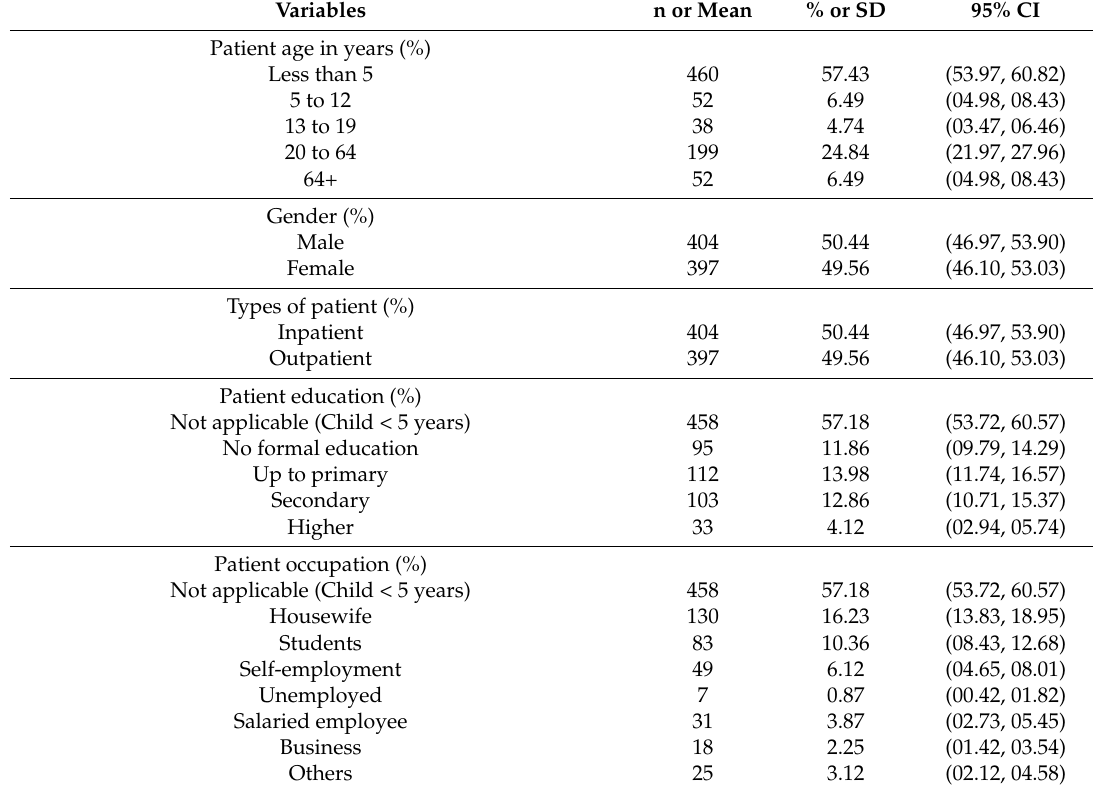
Table 1. Distribution of socio-demographic characteristics of diarrheal patients ( N =